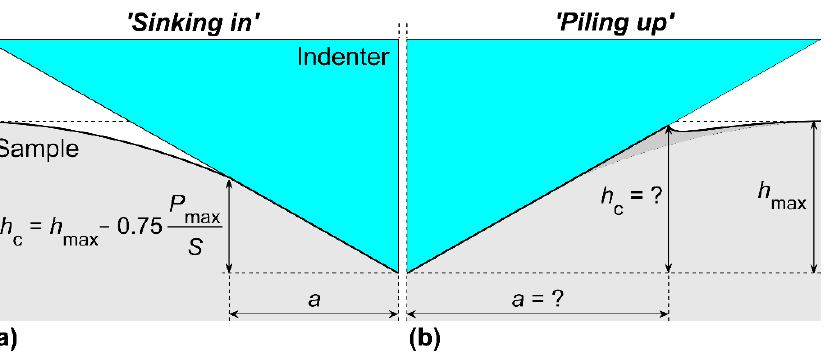
Figure 5. Surface profile upon sharp indentation of ( a ) an ideal elastic solid showing ‘sink-in’, and ( b ) elasto-plastic solid with little work-hardening characteristics showing ‘pile-up’ around the indenter.